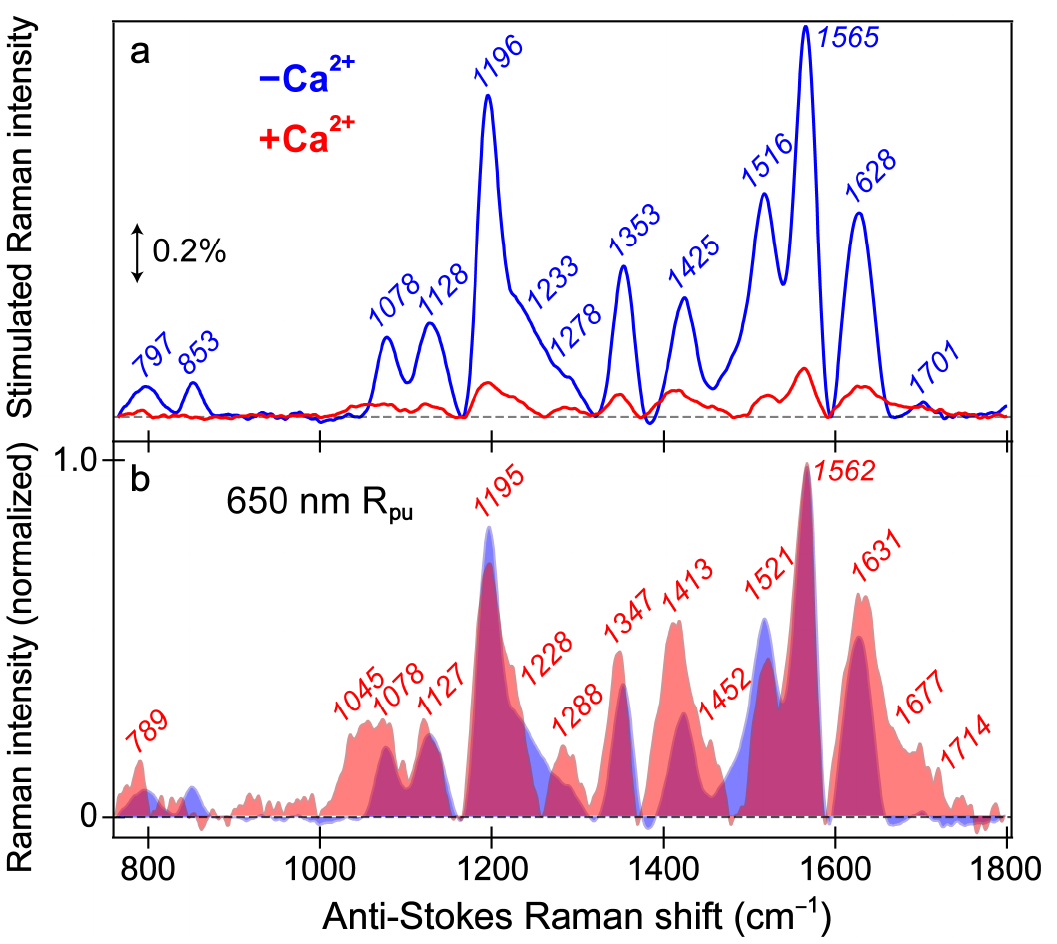
Figure 5. Ground-state FSRS spectra of REX-GECO1 without (blue) and with (red) calcium ions (Ca 2+ ) in pH 7 buffer. ( a ) FSRS spectra recorded with a 650 nm Raman pump (R pu ) and a bluer Raman probe on the anti-Stokes side. The double-arrowed line represents the stimulated Raman intensity magnitude of 0.2%. The stimulated Raman shift axis is multiplied by –1 to show positive vibrational frequencies. ( b ) The normalized FSRS spectra enhance peak comparisons with the magenta shade highlighting the overlapped Raman peaks of the Ca 2+ -free (blue shade) and Ca 2+ -bound (red shade) biosensors. The peak center frequencies (color-coded) from least-squares gaussian fits are listed for both biosensor states.